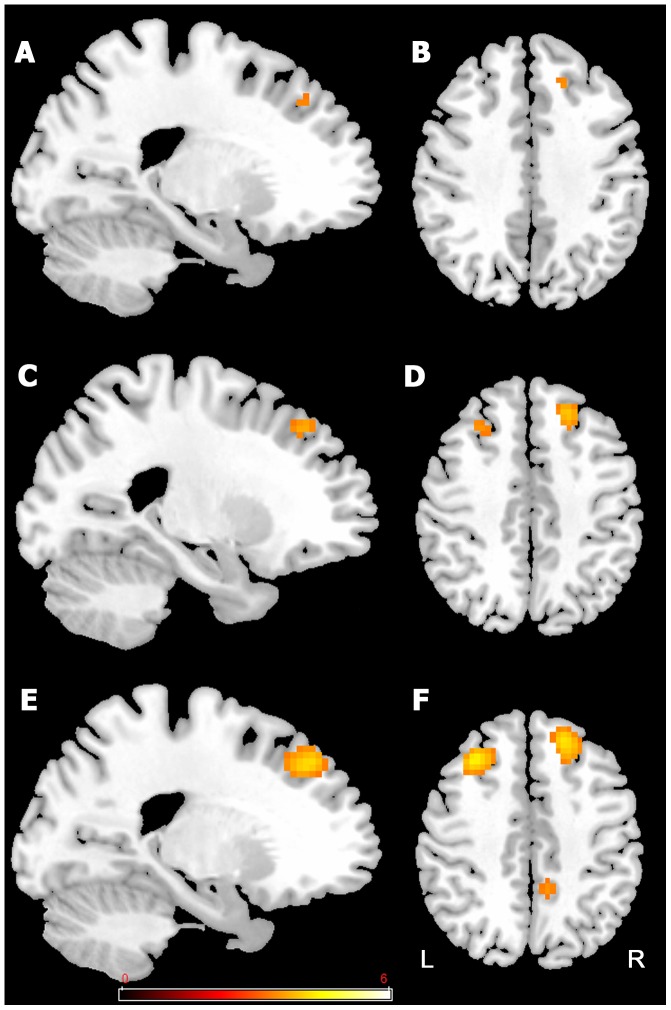
Activations related to dual-tasking prior to training (pre-training session).Network of prefrontal activation in dual-task, with more emphasis on equation (80% Equation (80/20)) in A and B; equal division of attention (50% Equation (50/50)) in C and D; and more emphasis on detection (20% Equation (20/80)) in E and F. The threshold for display is P<0.001, uncorrected, 10 voxels. Coloured bar is representative of t scores mentioned in Table 5. “L” denotes the left side of the brain, while “R” denotes the right side.